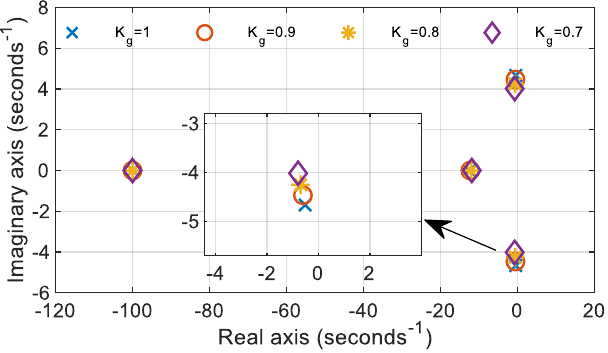
Figure 4. Root locus of the AVR system.